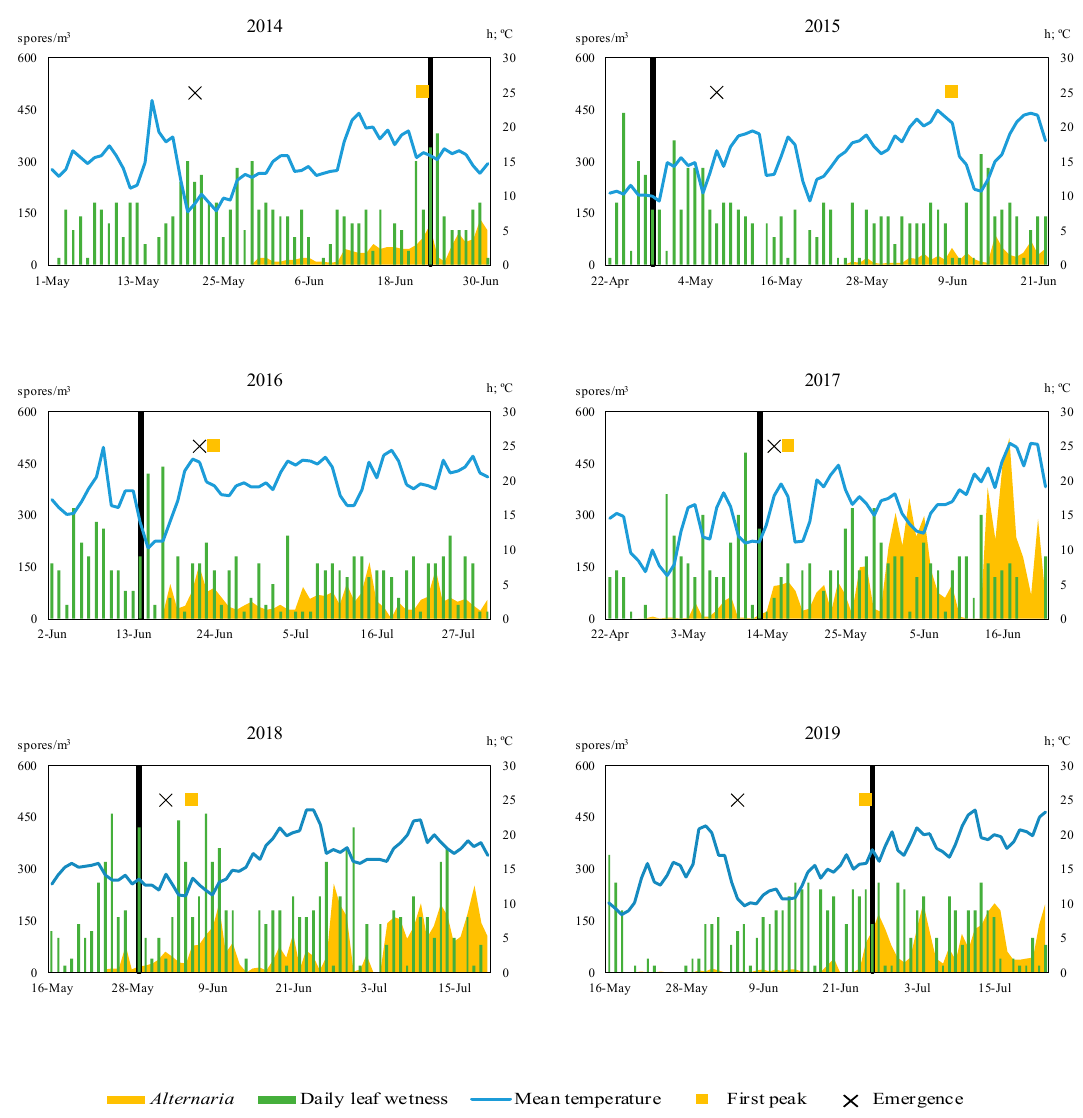
Figure 2. Distribution of daily Alternaria concentration, daily air mean temperature, hours of daily leaf wetness during first weeks of growing seasons. The black bar shows results of the adaptation of TOMCAST model by growing season.